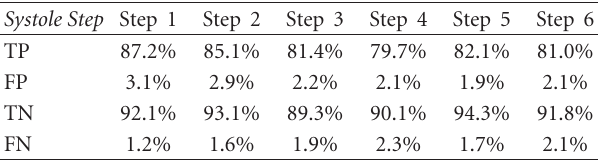
Table 1: Average number of each type of pixels (expressed in percentage of the average total number of pixels of each pixel class within manual generated myocardium surface) for each of the 6 considered time steps of the systole.